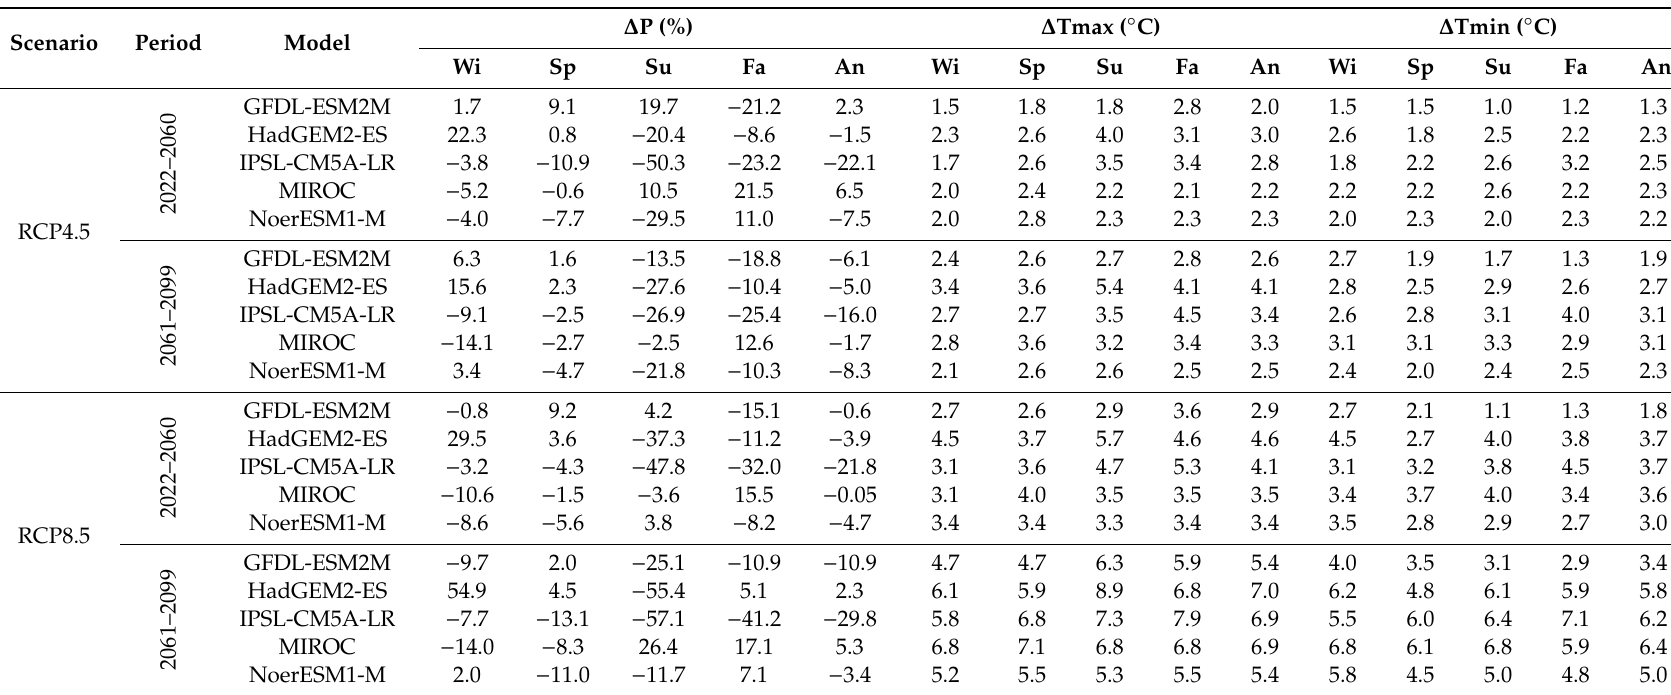
Table 2. The possible alterations in the annual and seasonal average maximum temperature (Tmax), minimum temperature (Tmin), and precipitation (Pr) in the Vakhsh River Basin in Central Asia in the two future time periods for the winter (Wi), spring (Sp), summer (Su), fall (Fa), and annual (An) time scales. Scenario